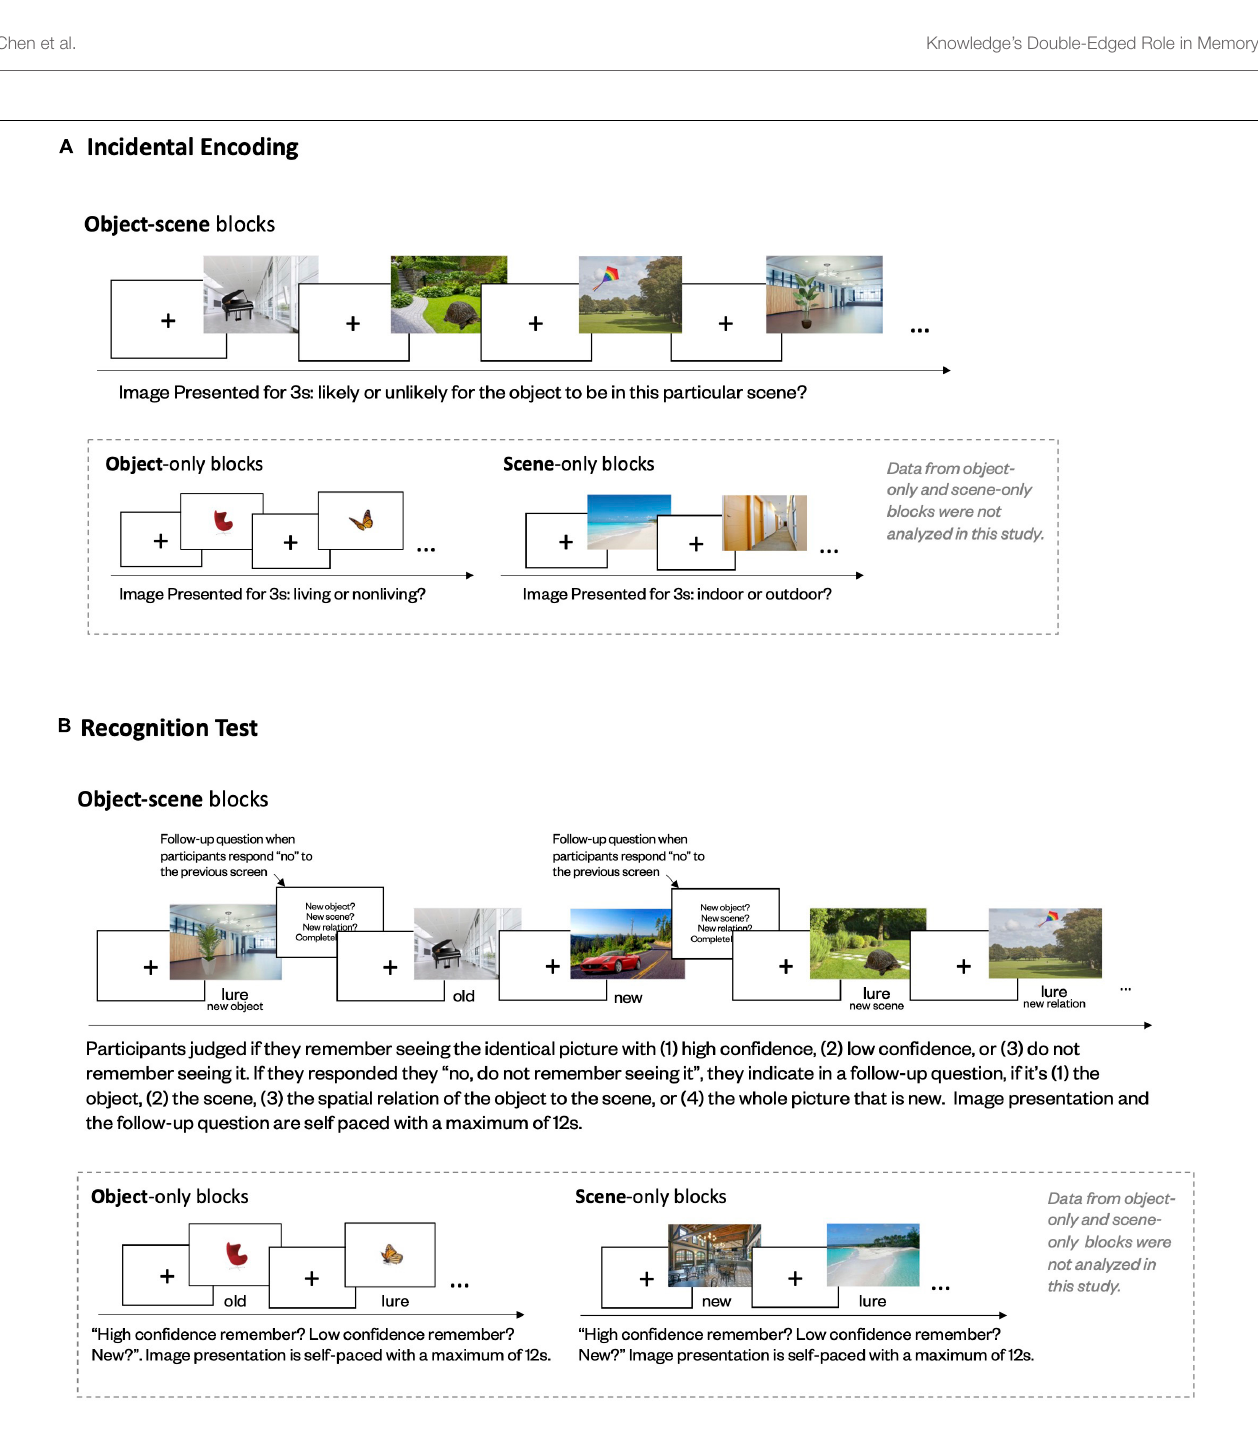
FIGURE 1 | Experimental paradigm for encoding (A) and retrieval (B) phases in memory task.